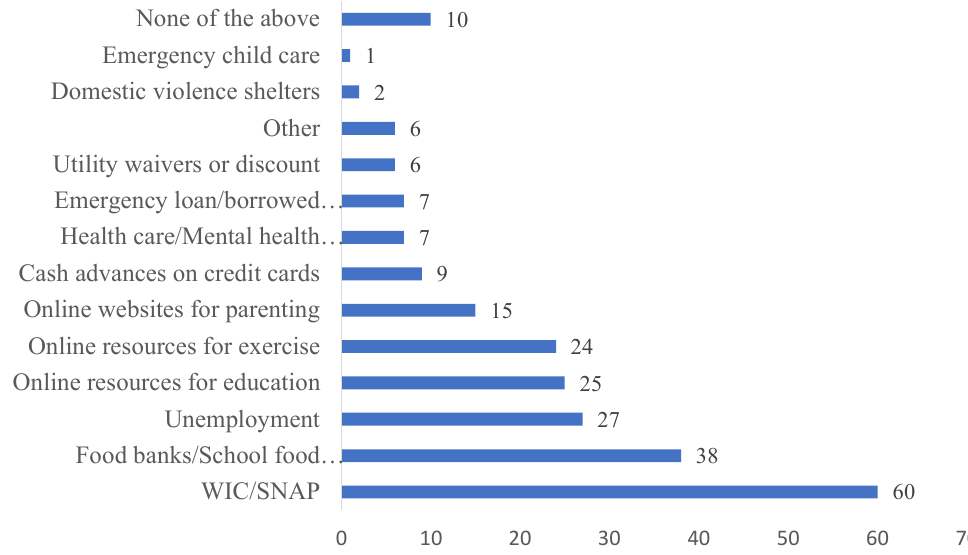
Figure 1. Economic, services, and resources used early on in the COVID-19 pandemic. Note. Number of families (n = 95) who reported use of each type of resources since the COVID-19 crisis began.